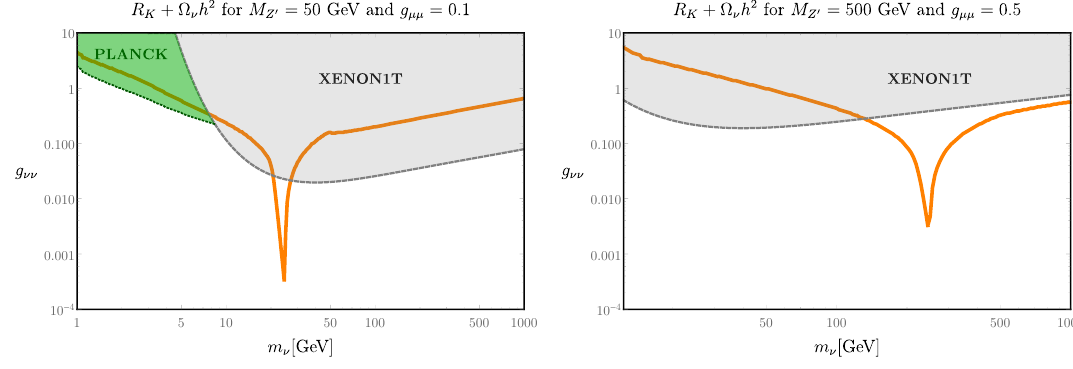
Figure 5 . Direct and indirect detection constraints on the parameter space: the orange line represents the model points featuring the correct dark matter relic density and the appropriate Wilson coe(cid:14)cient explaining the R K discrepancy. The gray region shows the parameter space excluded by the XENON1T experiment [95] and the green region represents the parameter space not excluded by direct detection experiments but in tension with the Planck collaboration [82]